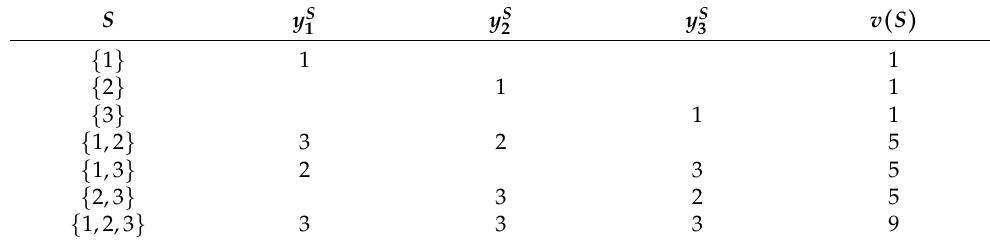
Table 2. PMAS profit game ( N , v , (cid:23) ) for Example 5. S y S v ( S ) y S y S 2 3 1 { 1 } 1 1 { 2 } 1 1 { 3 } 1 1 { 1,2 } 3 2 5 { 1,3 } 2 3 { 2,3 } { 1,2,3